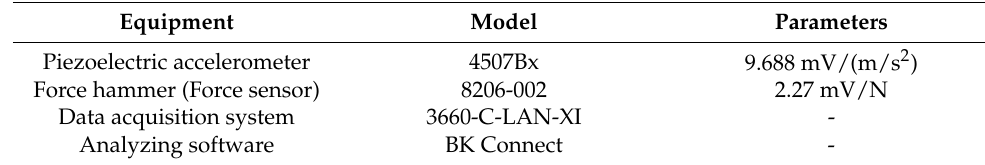
Figure 5. Hammer experiment bench installation diagram.